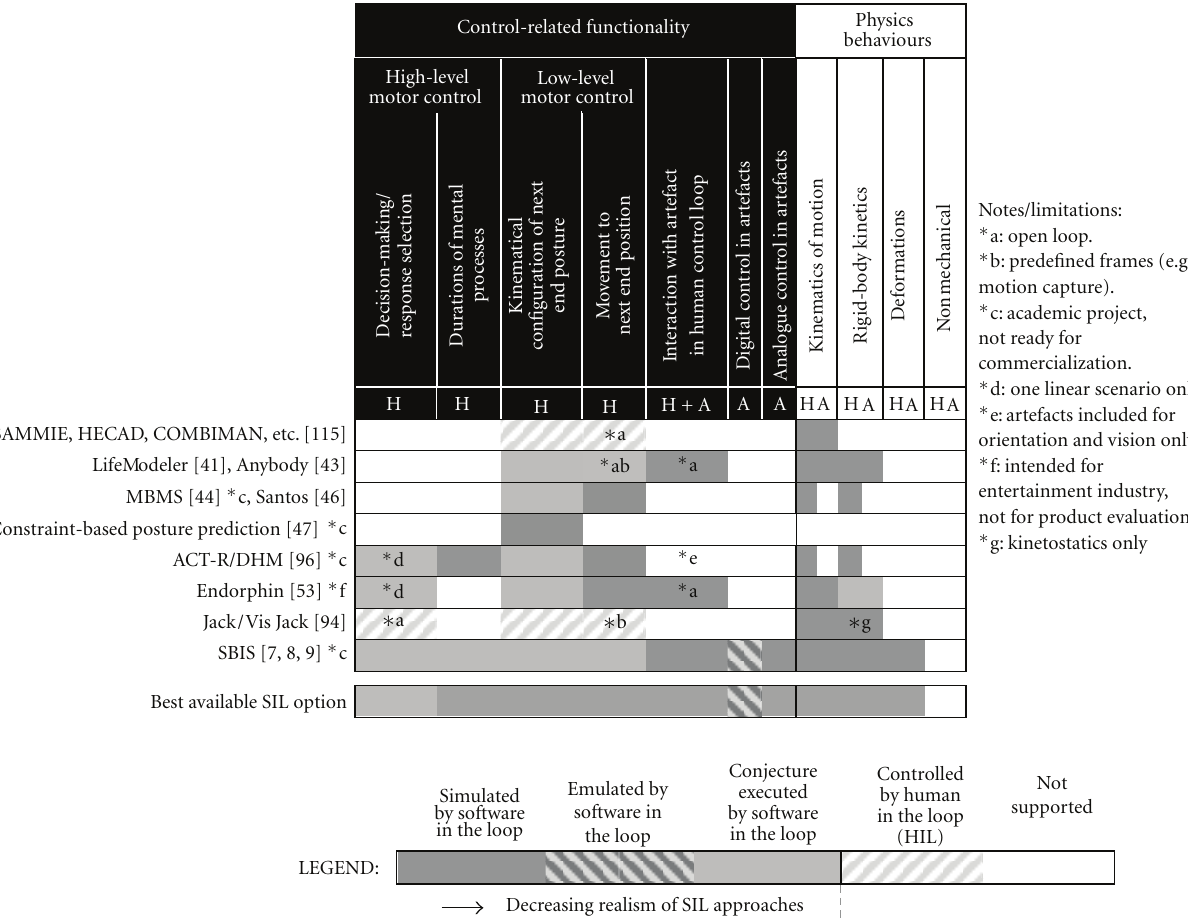
Figure 7: Review of full-body human simulations based on their